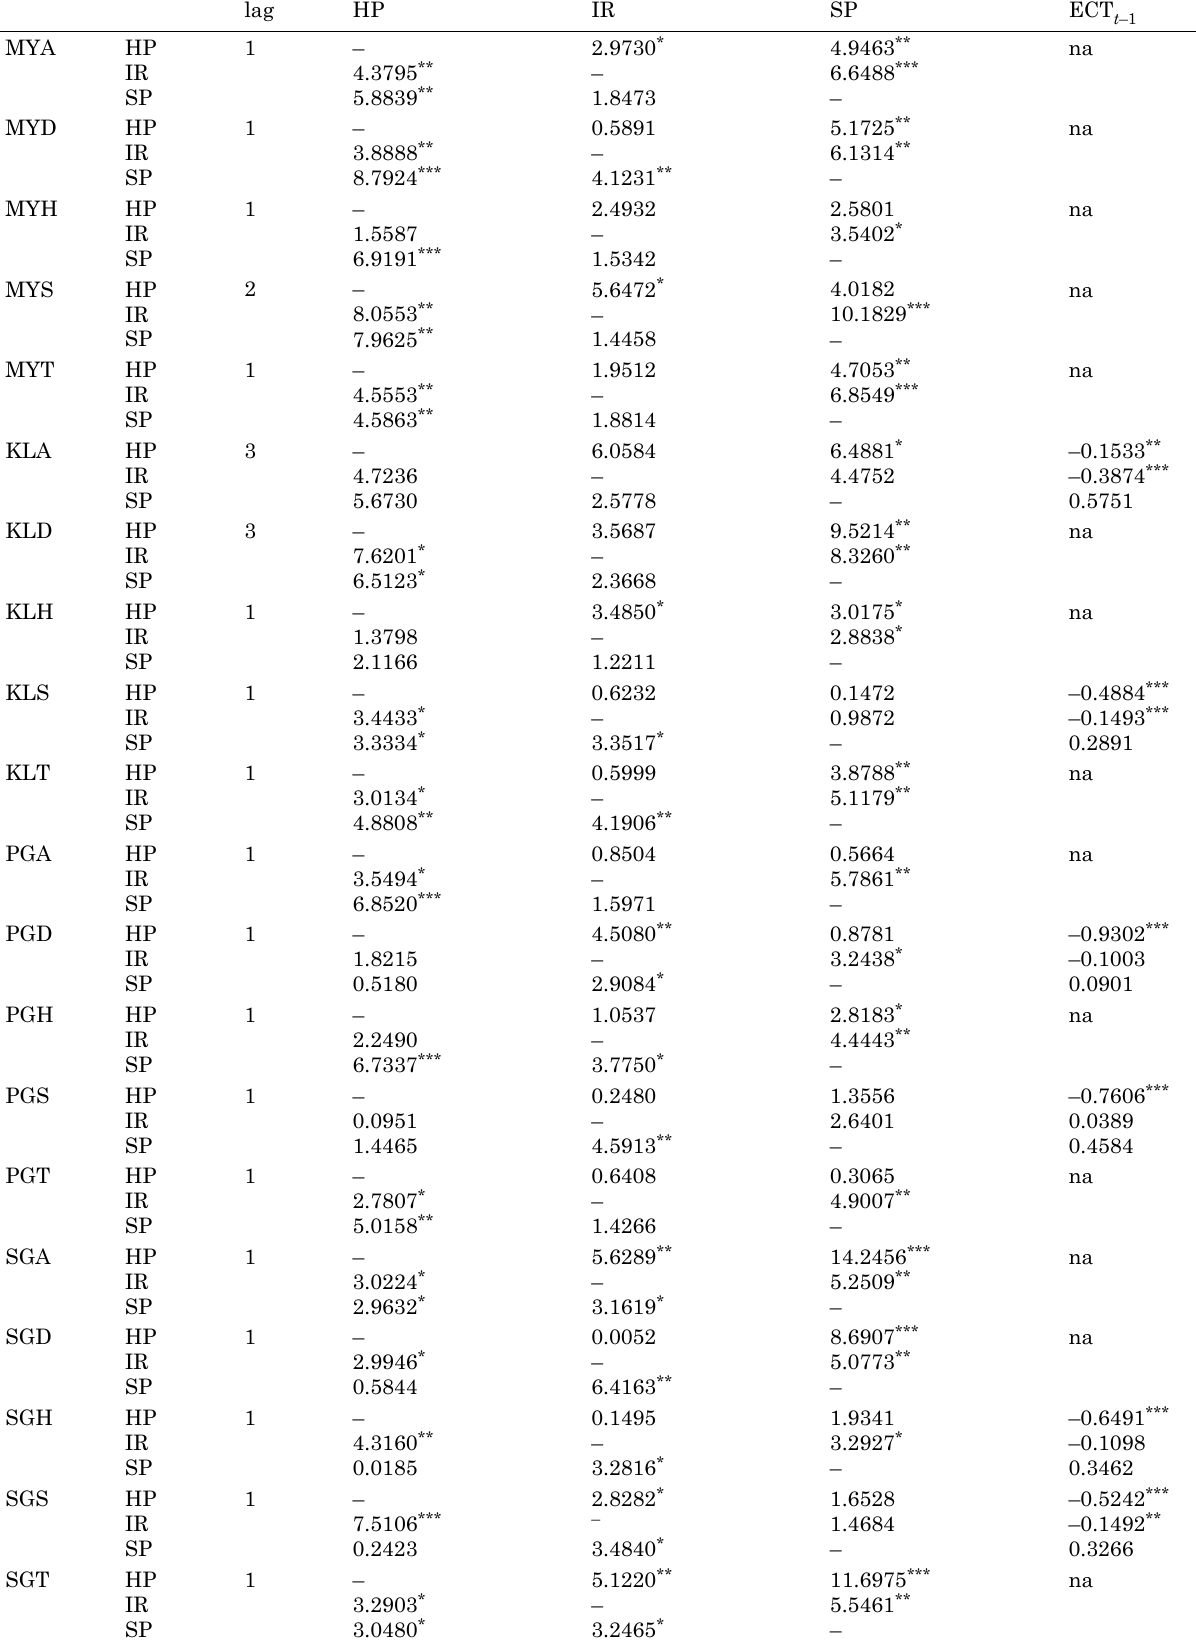
Table 4. Granger causality